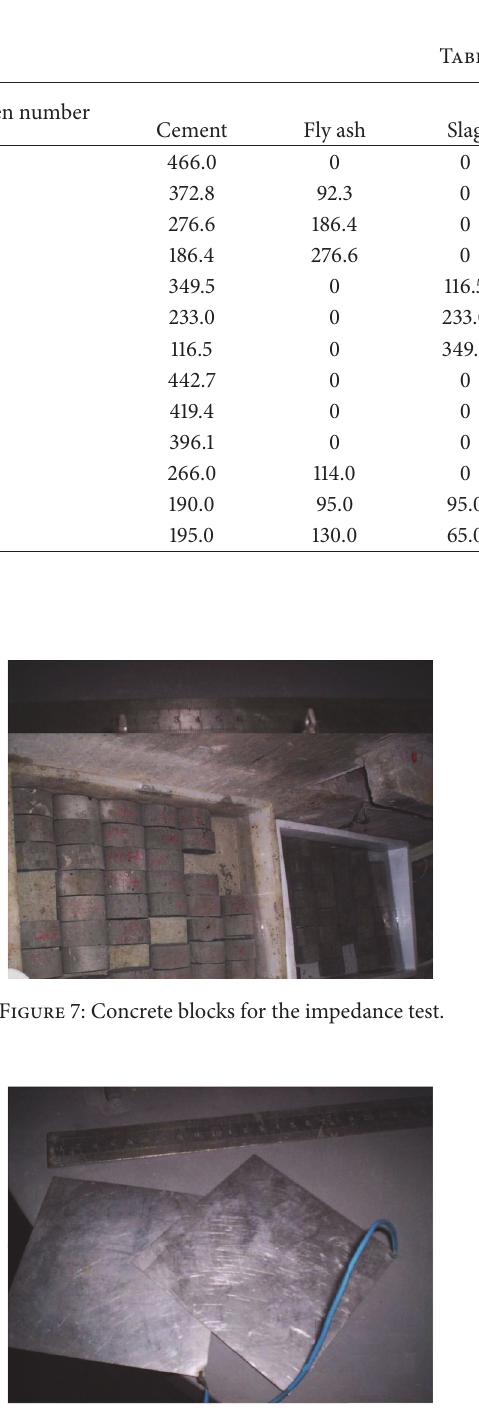
Figure 10: Impedance